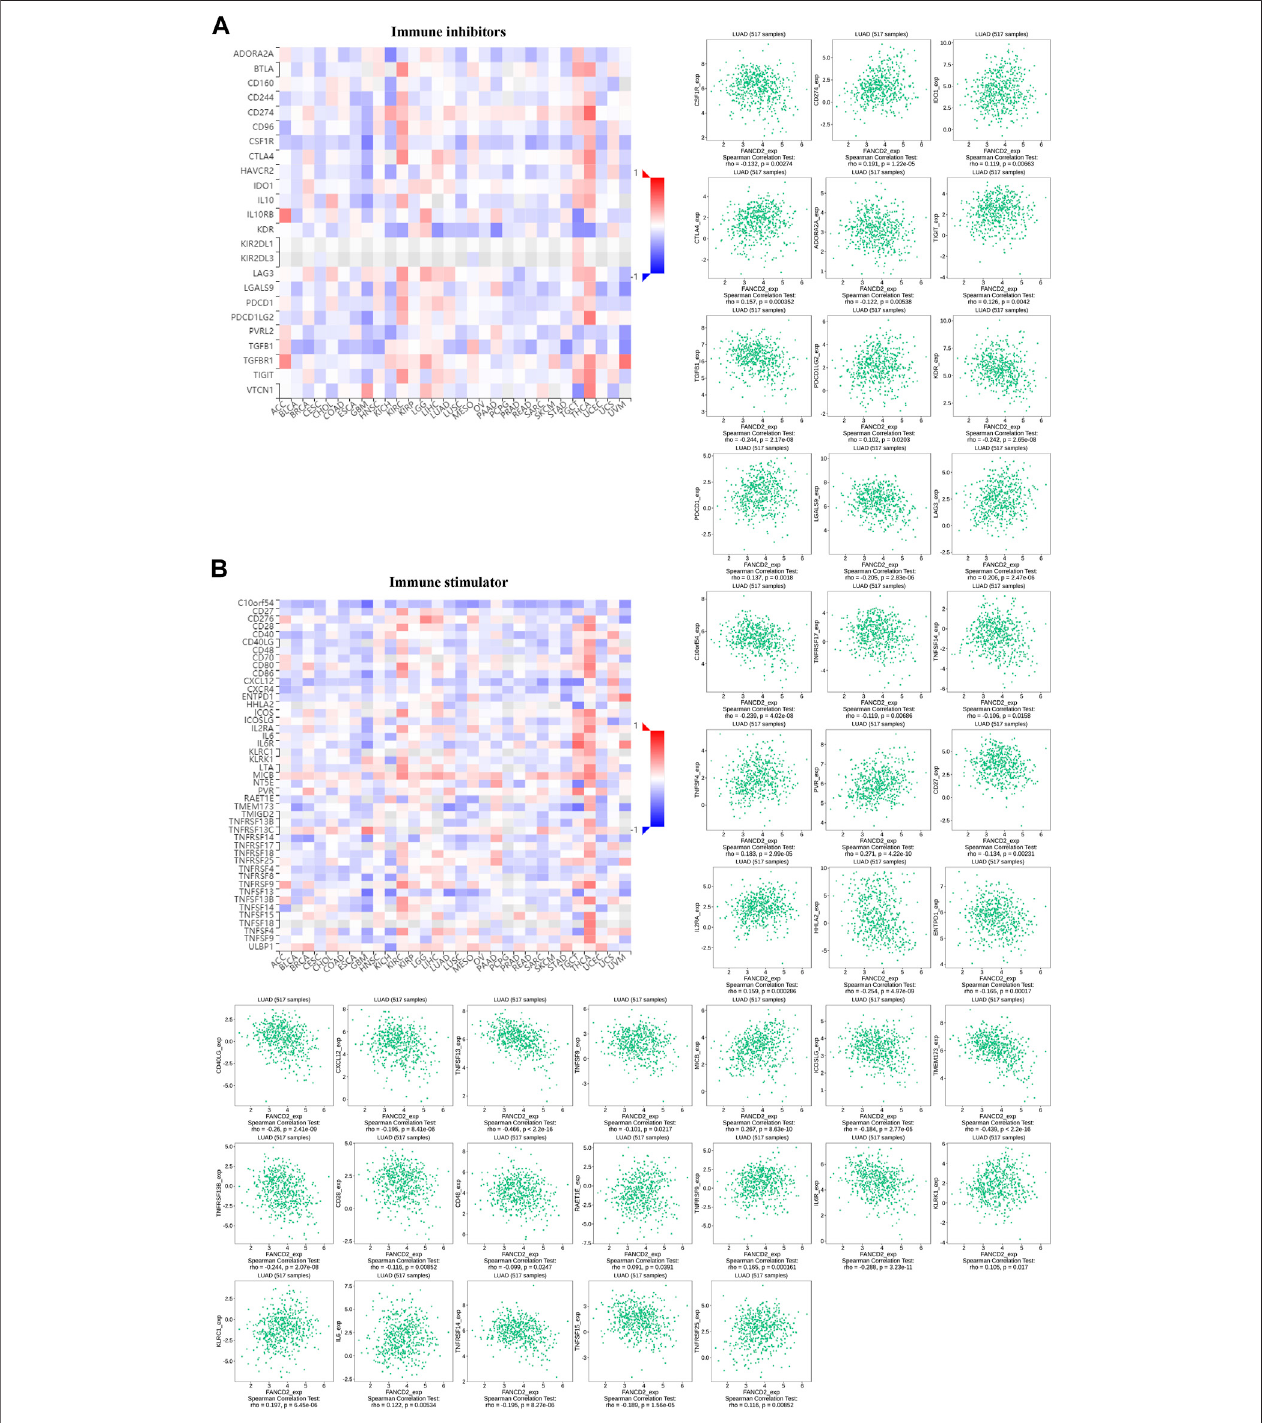
FIGURE 8 | Co-expression analysis of FANCD2 with immunoinhibitory (A) and immunostimulatory genes (B) in the pan-cancer database, as well as detailed information on LUAD.